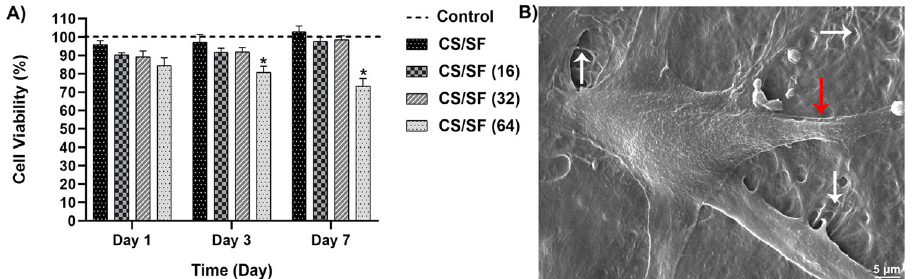
Fig. 6 A Cell viability results of the 4 investigated bilayer scaffolds with different concentrations of the peptide, show a signi fi cant dif- ference in fi broblasts ’ growth of peptide-loaded CS/SF (64 µg/ml